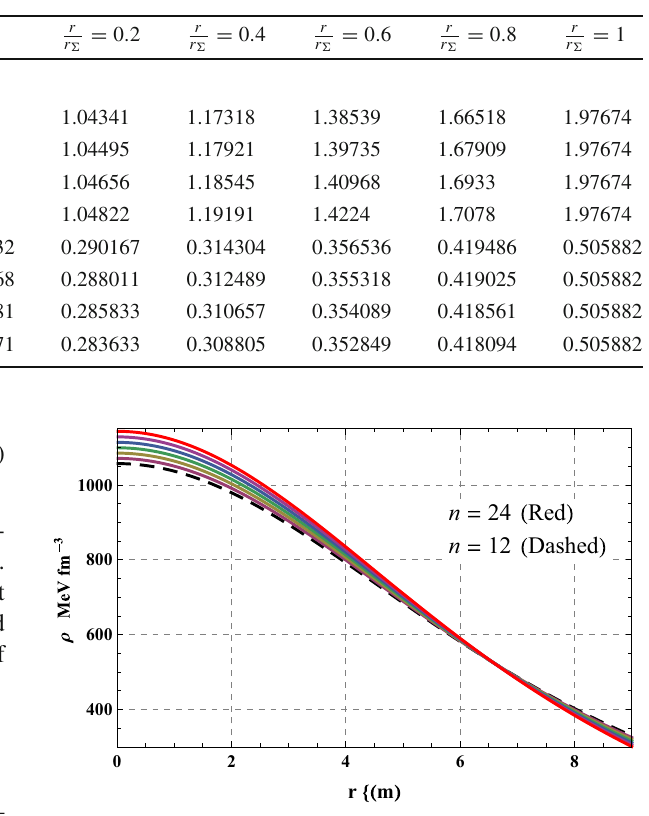
Fig. 2 Variation of density with radial coordinate for the parameters given in Table 1